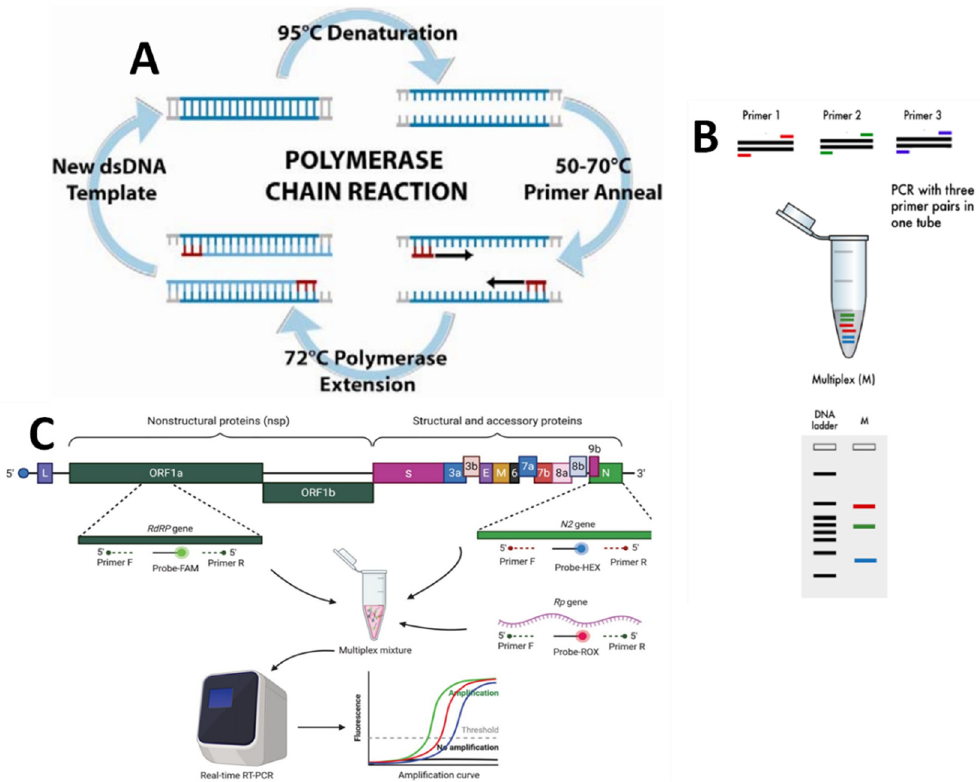
Figure 4. Schematic illustration of a molecular detection method: ( A ) the polymerase chain reaction (PCR) amplification process (adapted from Ref. [35]); ( B ) multiplex PCR (reproduced from Ref. [36]); ( C ) reverse transcriptase PCR (reproduced from Ref. [37]).